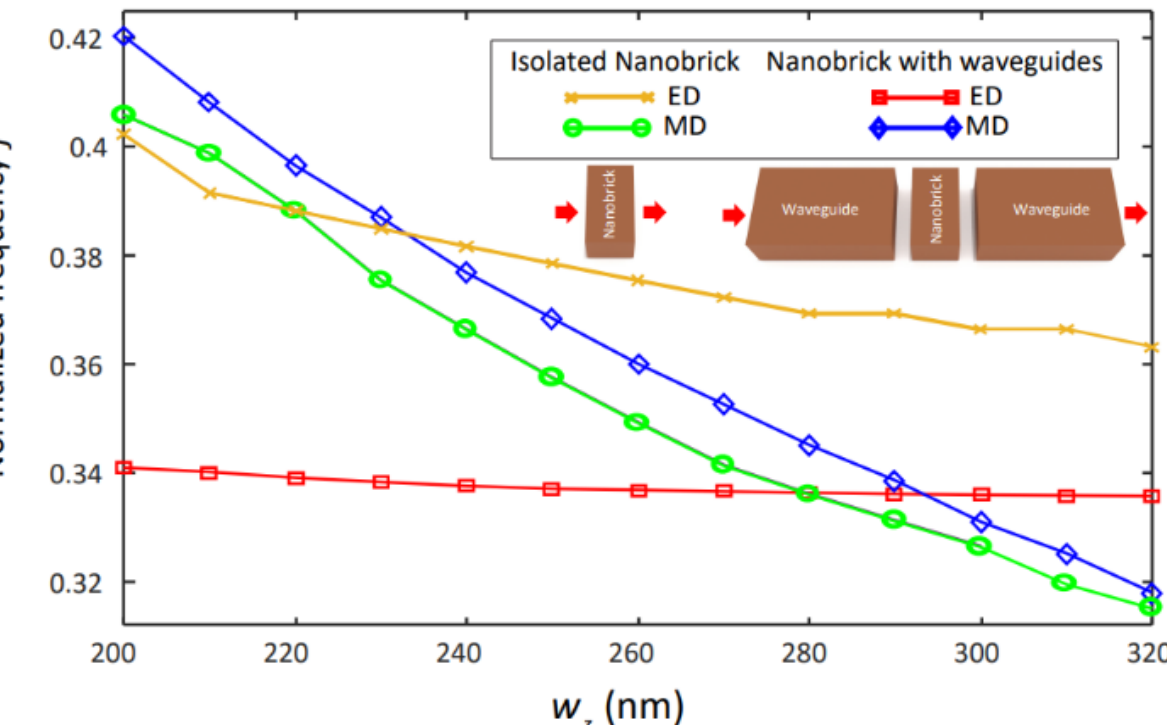
Figure 3. E y field maps at the boundary of the first Brillouin zone for the dielectric (left column) and air (right column) bands at different values of w z . For w z = 260 nm (middle panels) the frequency difference between the two bands is negligible, meaning that they are close to the degeneracy point.